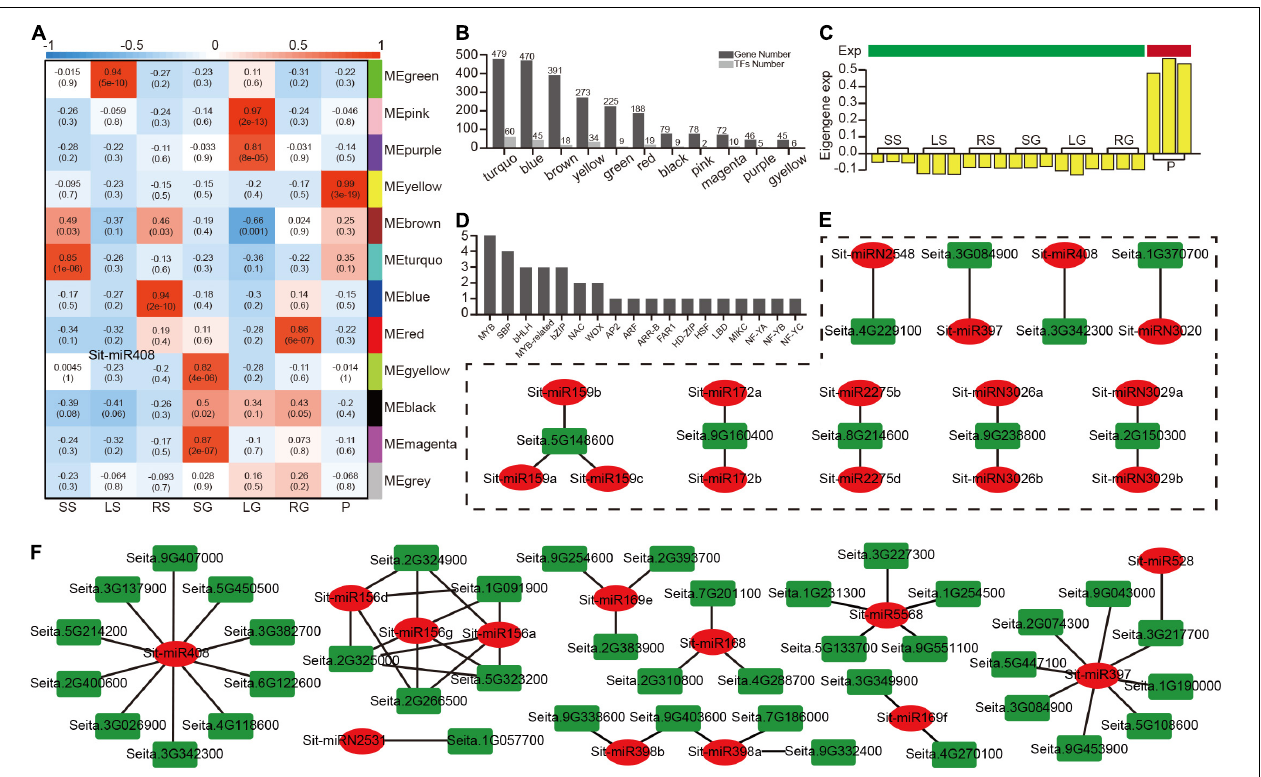
FIGURE 5 | A miRNA modules analysis based on a WGCNA analysis of 2,350 target genes. (A) A heatmap of 12 modules correlated with seven tissues. (B) The number of target genes and transcription factors in 11 modules (except for the non-sense gray module). (C) The bar plot of eigengene expression from the panicle-related yellow module. (D) The number of detailed transcription factors in the yellow module. (E) The regulatory modules between the nine highest-connectivity target genes in the yellow module and their relevant miRNAs. (F) The regulatory modules between the target genes and their relevant miRNAs with opposite patterns of